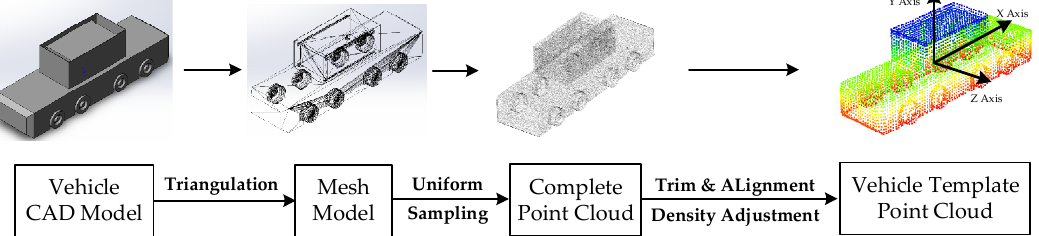
Figure 6. Template point cloud acquisition procedure in the simulated test environment.